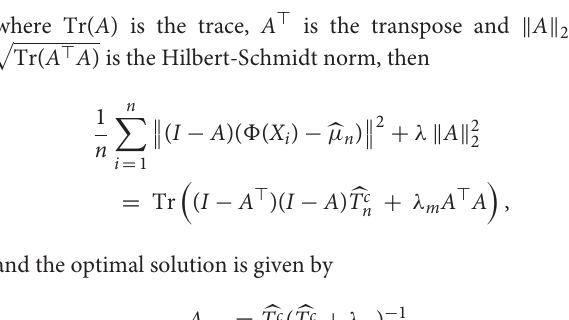
5,20,30,50, τ 0.4,0.35,0.3,0.2. = =